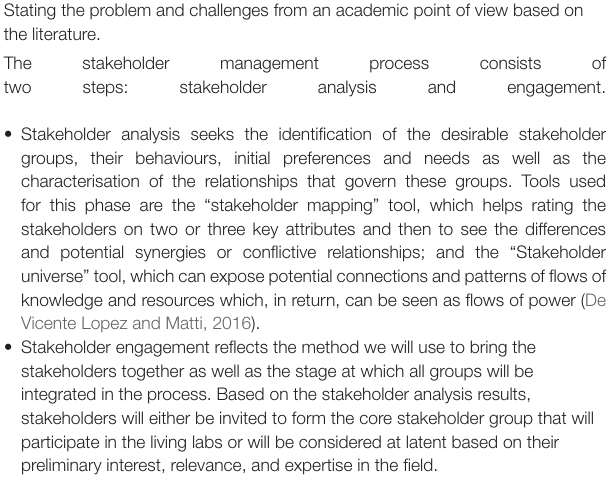
TABLE 1 | The stages of the SIA process (indicative as any problem, stakeholder group, and solutions differ). Stating the problem and challenges from an academic point of view based on the literature. The stakeholder management process consists of two steps: stakeholder and